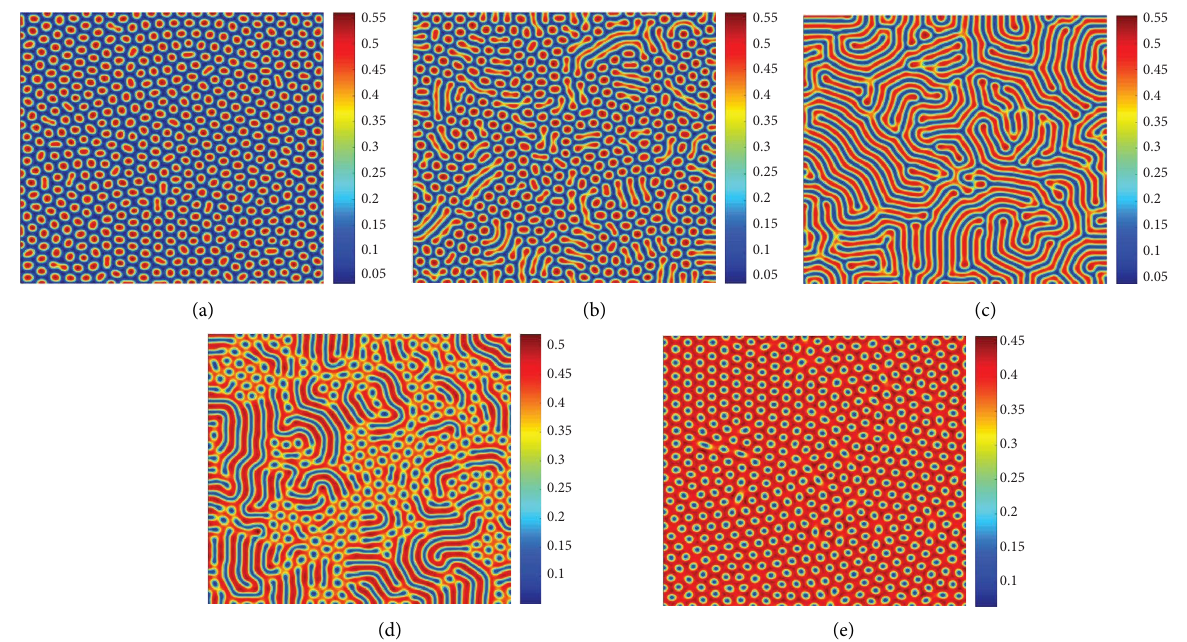
Figure 7: Patterns transitions induced by interval parameter c . (a) q � 0, (b) q � 0 . 3, (c) q � 0 . 7, (d) q � 0 . 85, and (e) q � 1.